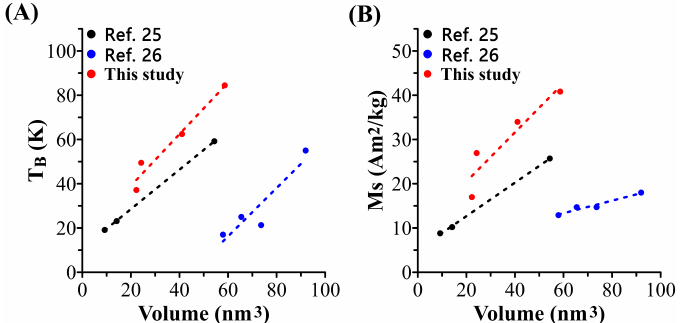
Figure 3. ( A ) influence of nanoparticle volumes on blocking temperature (T B ) and ( B ) saturation magnetization (Ms) (300 K). Dotted line is the linear fitting of the